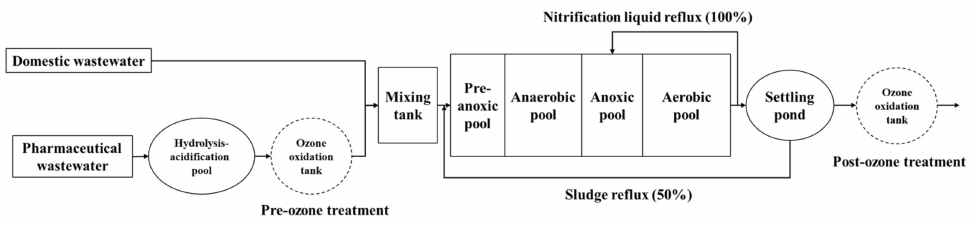
Figure 2. The flow chart of the hydrolysis–acidification–ozone oxidation-improved A 2 / O